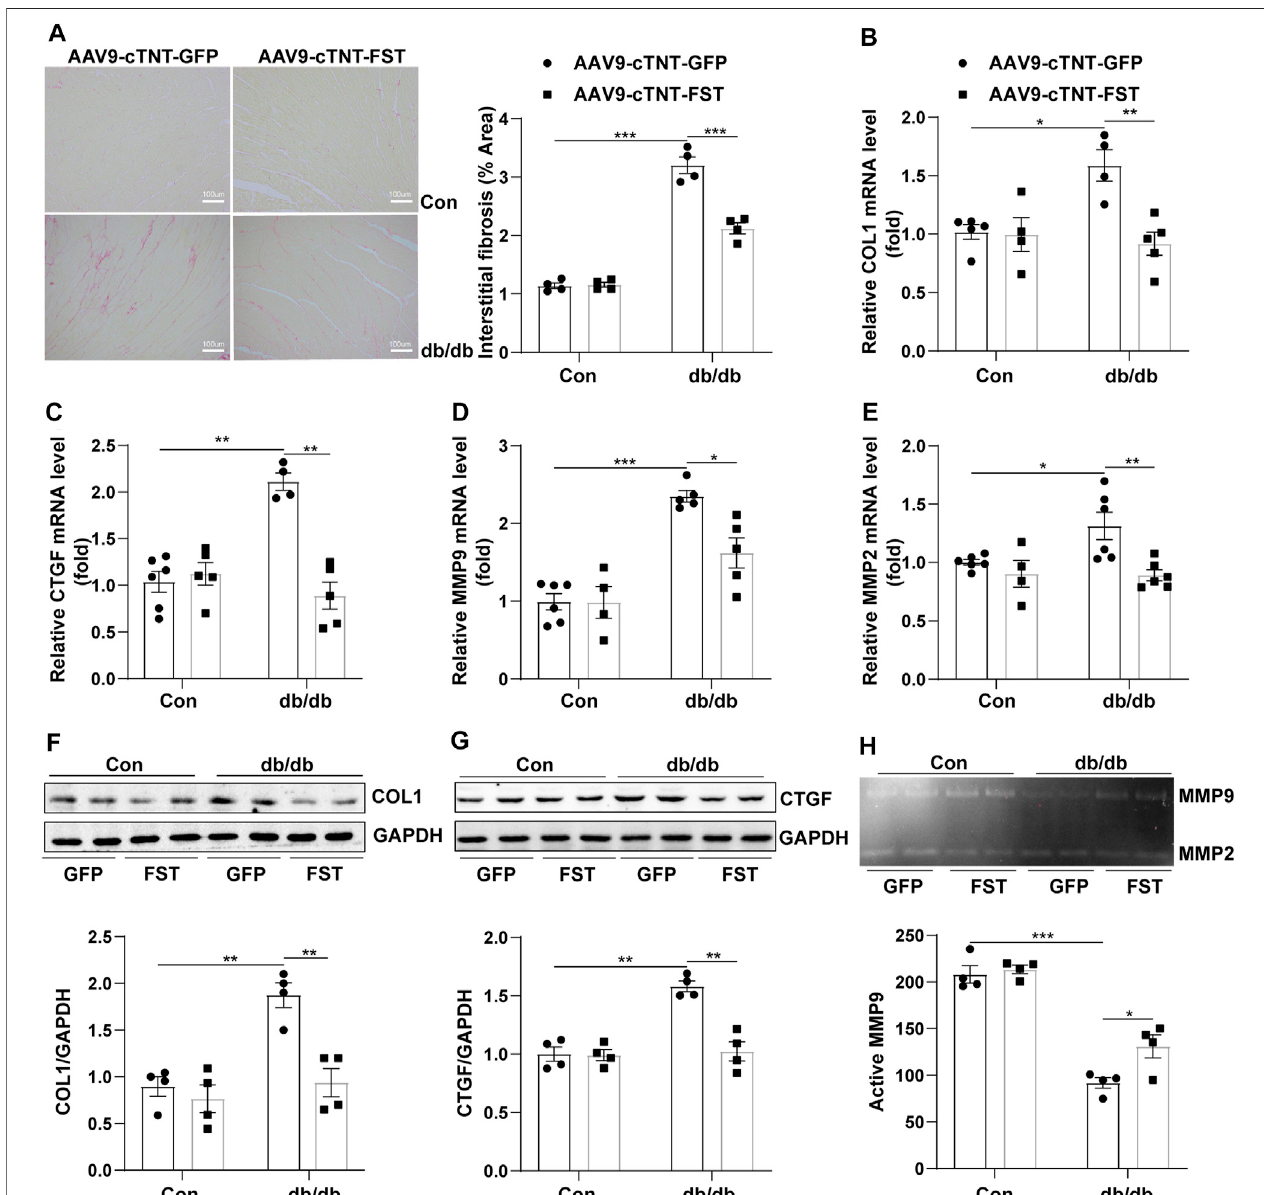
FIGURE 4 | Overexpression of FST abrogates cardiac fi brosis. Representative images of Sirius red staining and quantitative analysis of myocardial interstitial collagen (magni fi cation: 200 × [ (A) , n (cid:1) 4]). Quantitative real-time PCR analysis of mRNA transcription of fi brosis markers COL1 and CTGF [ (B, C) , n ≥ 4]. Western blotting and quantitative analysis of COL1 and CTGF [ (F, G) , n (cid:1) 4]. Quantitative real-time PCR analysis of mRNA transcription of MMP9 and MMP2 [ (D, E) , n ≥ 4] and activity measured by zymography [ (H) , n (cid:1) 4] in each group. * p < 0.05; ** p < 0.01; *** p < 0.001.